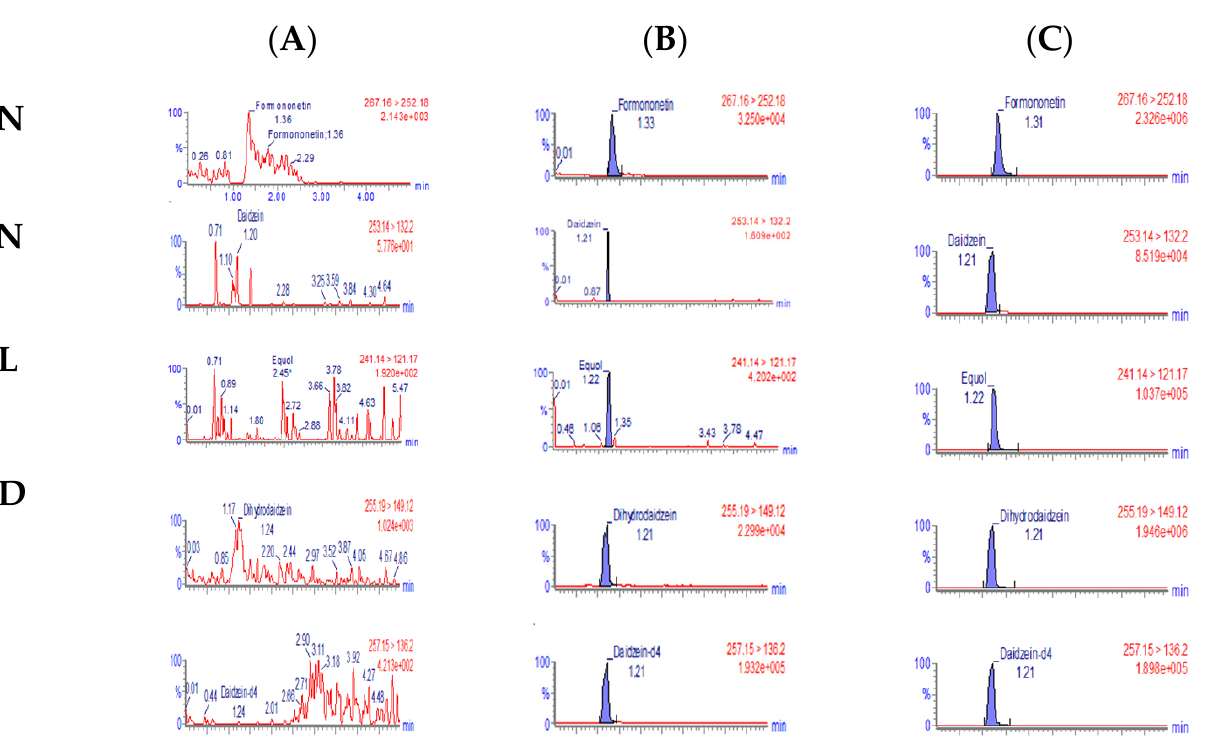
Table 1. The precision and Accuracy of the determination of FMN, DZN, DHD and EQL in rat plasma.